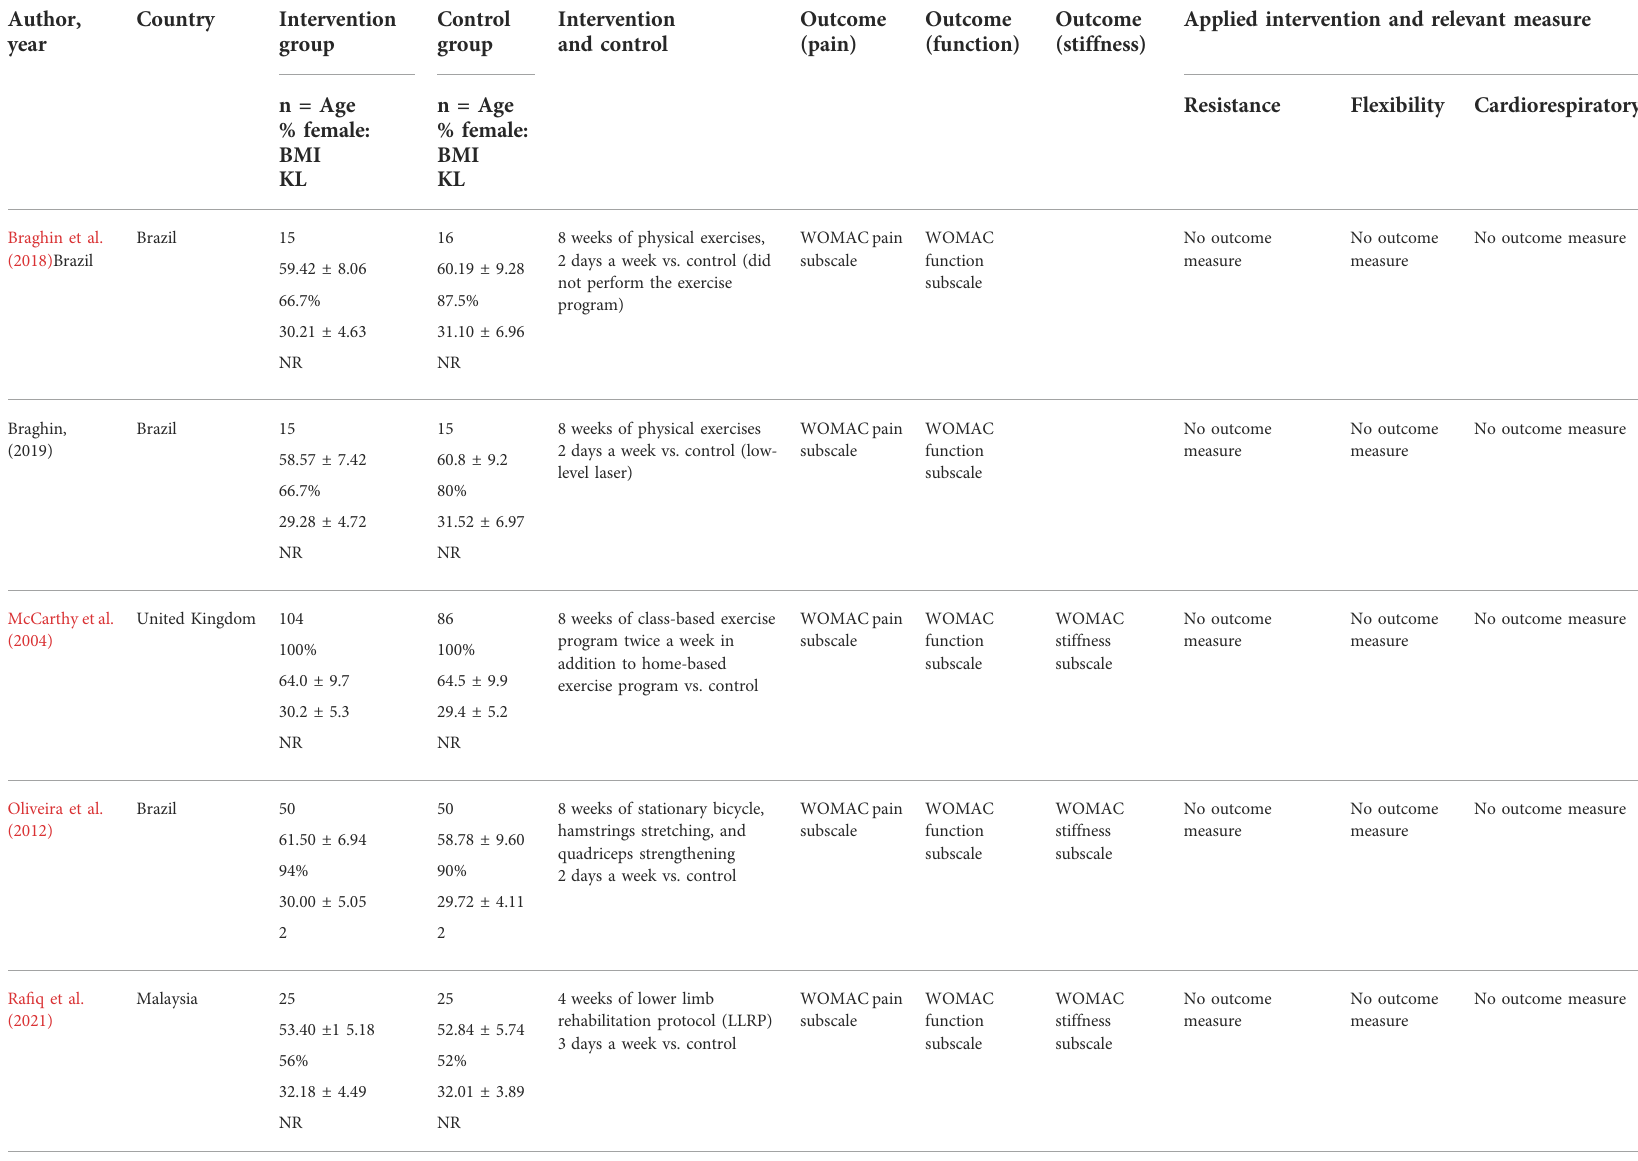
TABLE 4 Exercise interventions evaluated according to the American College of Sports Medicine ’ s (ACSM) recommendations.